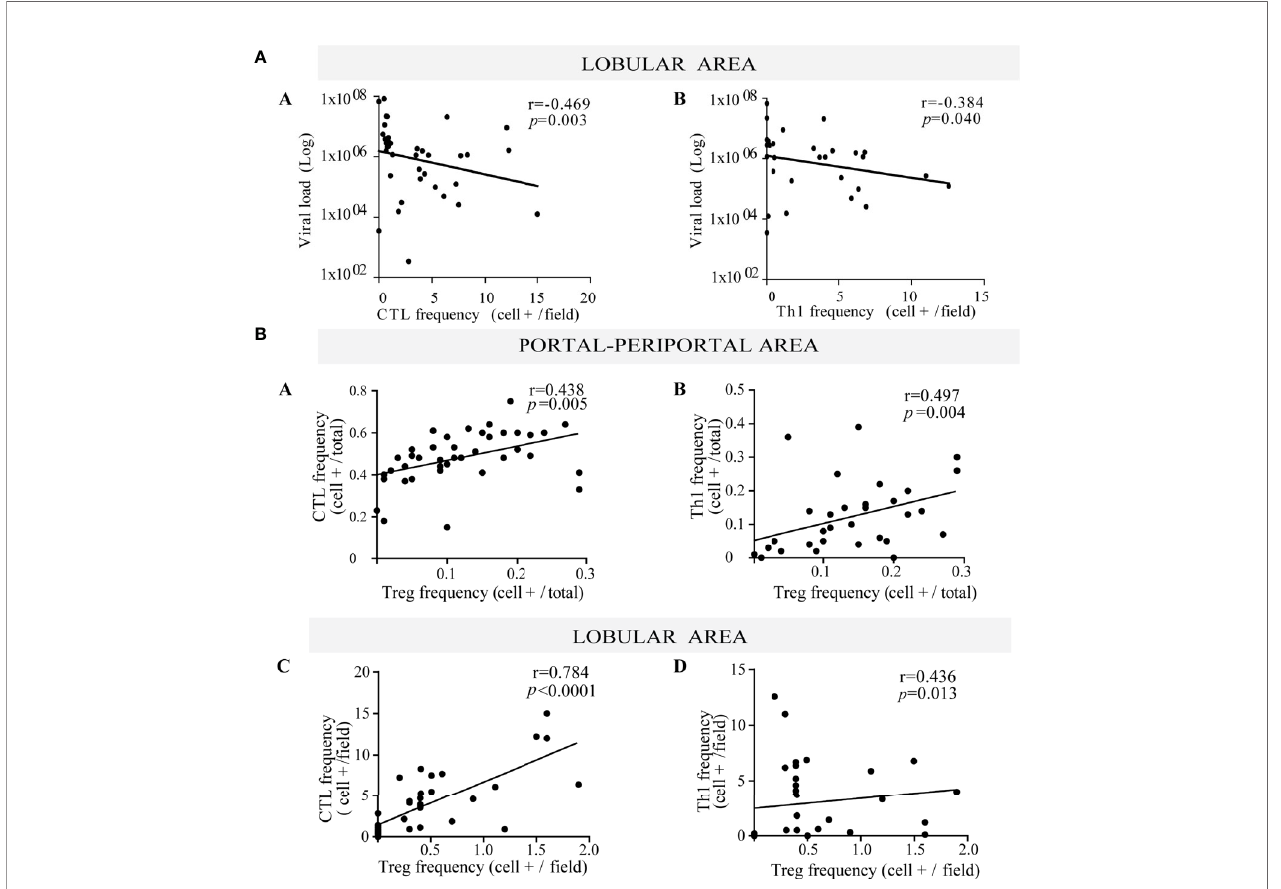
FIGURE 2 | (A) Relationship between viral load and frequency of both lobular CTL and Th1. Correlation between viral load and the frequency of lobular CTL (a) and Th1 (b). (B) Relationship between Treg lymphocytes with both CTL and Th1. Correlation between the frequency of Treg with CTL (a) and Th1 (b) at portal- periportal area. Correlation between the frequency of Treg with CTL (c) and Th1 (d) at lobular area. Spearman ’ s nonparametric correlation was used to compare these data